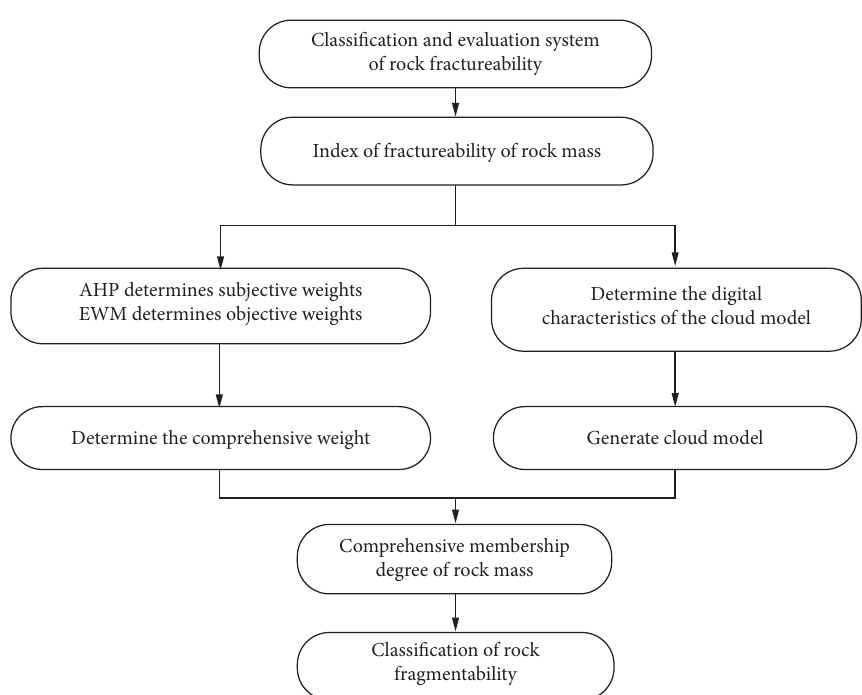
Figure 2: Flow chart of cracking